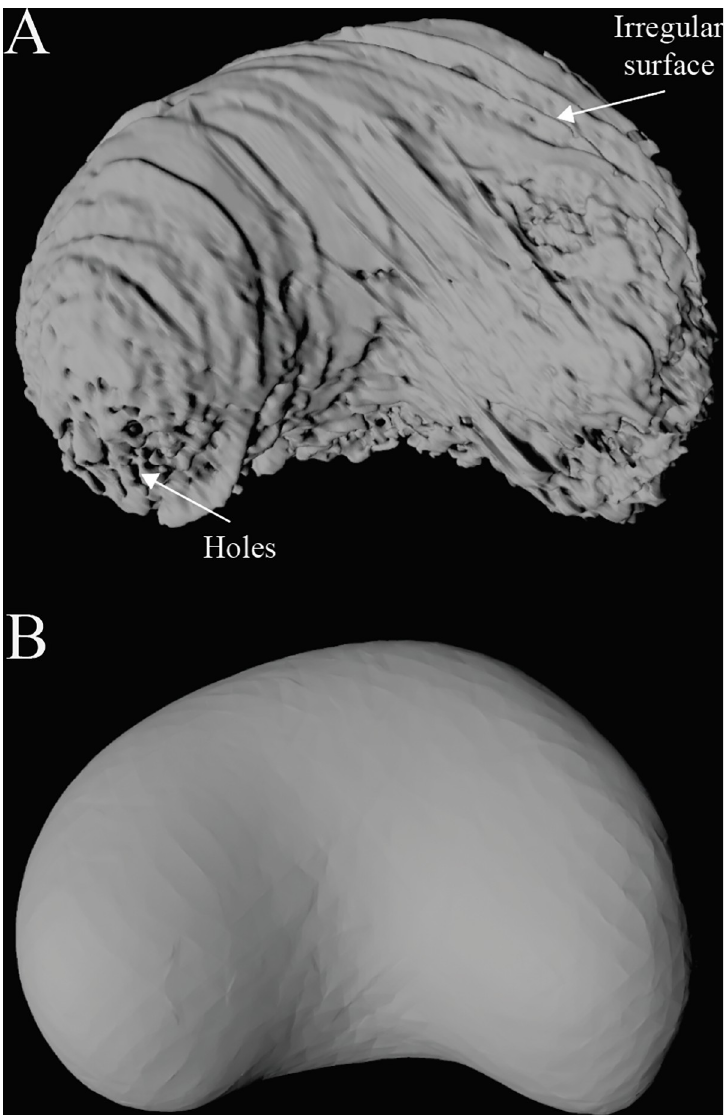
Fig 2. 3D reconstruction of Petriellaea triangulata [12], before (A) and after (B) post-processing. A. 3D mesh [12] exported directly from Avizo version 9.2.0 (Thermo Fisher Scientific, Massachusetts, USA). Object file exhibits many of the common issues described for fossil taxa, such as holes and irregular surfaces, which represent artefacts from preservation, low density contrast in the micro-CT image, and manual segmentation. B. 3D mesh file post-processed in Meshlab. Images generated using Autodesk